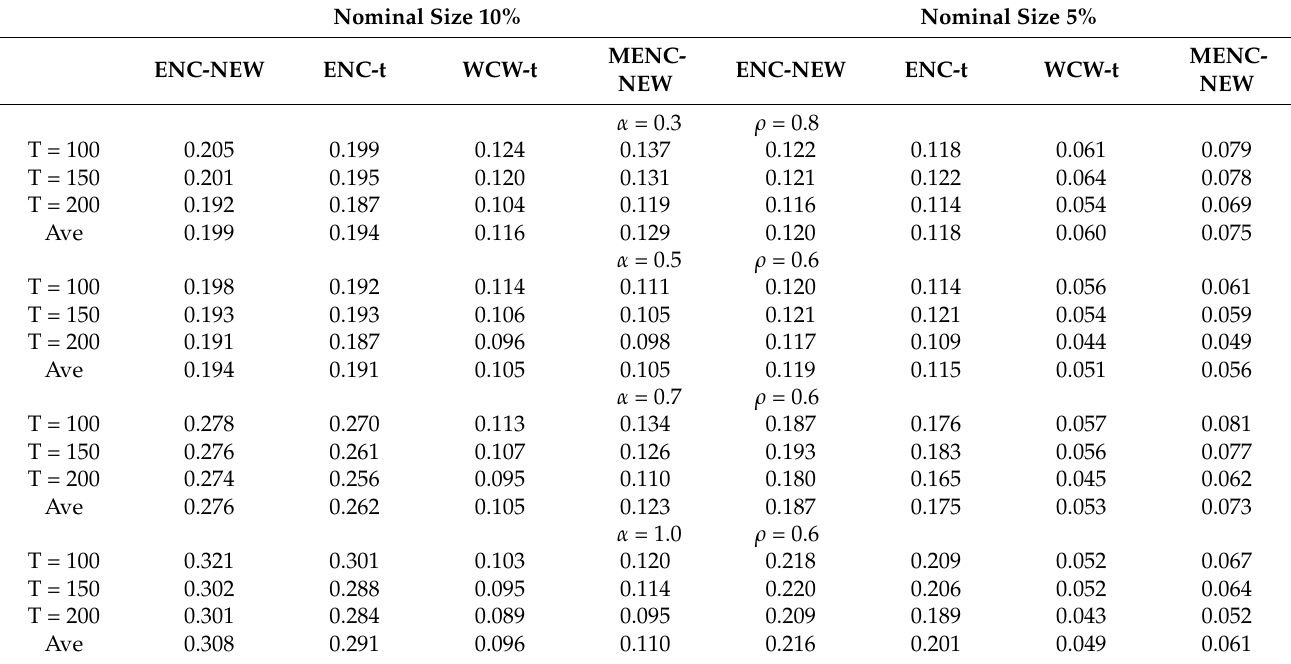
Table 2. Empirical Size for P/R =